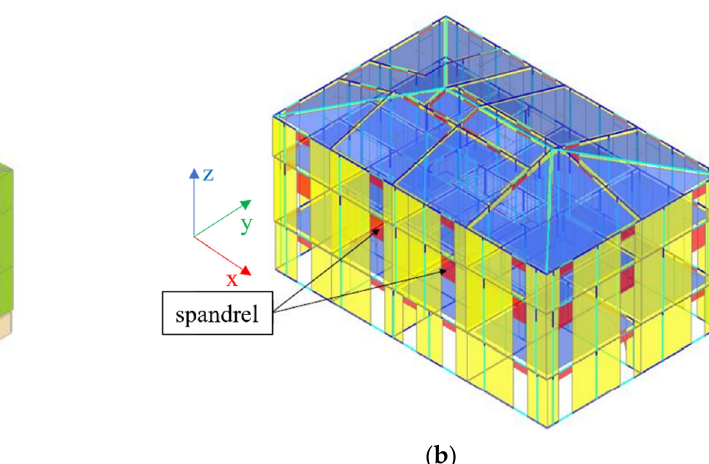
Figure 9. Retrofitted configuration of the wooden slabs (unit of measure in cm).